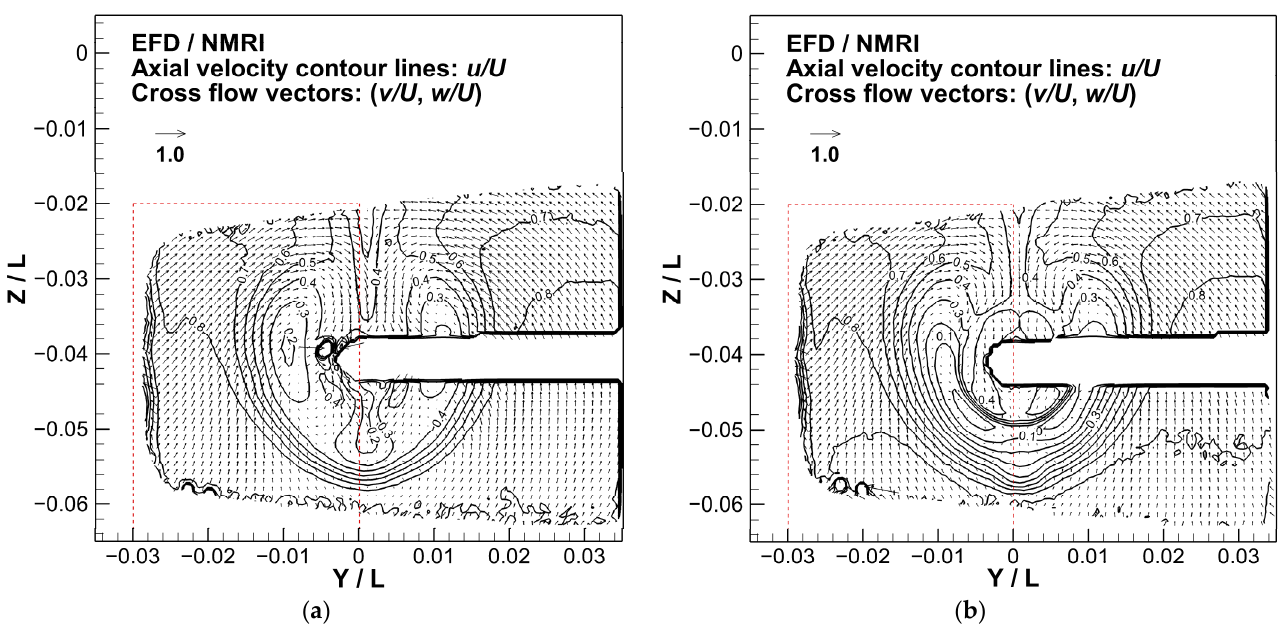
Figure 9. Experimental nominal wake velocity distribution ( a ) without duct and ( b ) with the original duct. (Provided by T2015 [11], NMRI = National Maritime Research Institute, Japan). The dashed lines indicate the region to compare with the CFD results.